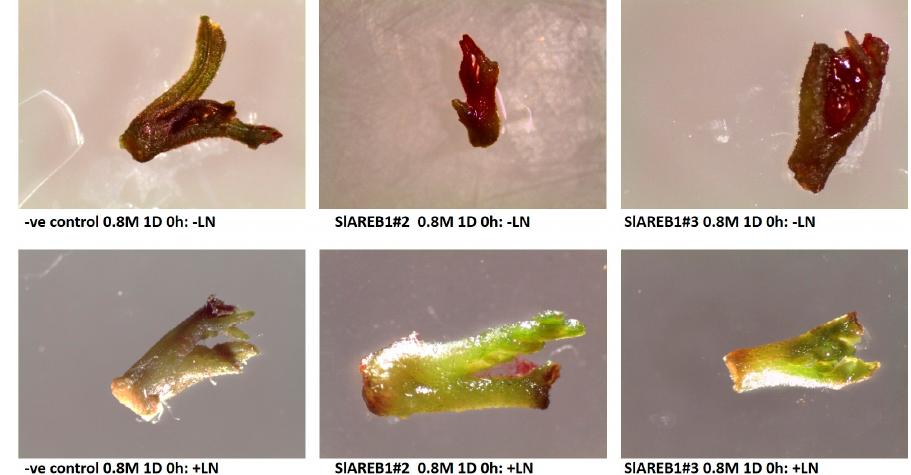
Figure 3. Survival of two transgenic lines overexpressing SlAREB1 (SlAREB1#2 and SlAREB1#3) and negative control (-ve control) shoot tips after encapsulation dehydration treatment of 1 day (1 D) incubation in 0.8 M sucrose and 0 h dehydration with (+LN) or without liquid nitrogen ( − LN).